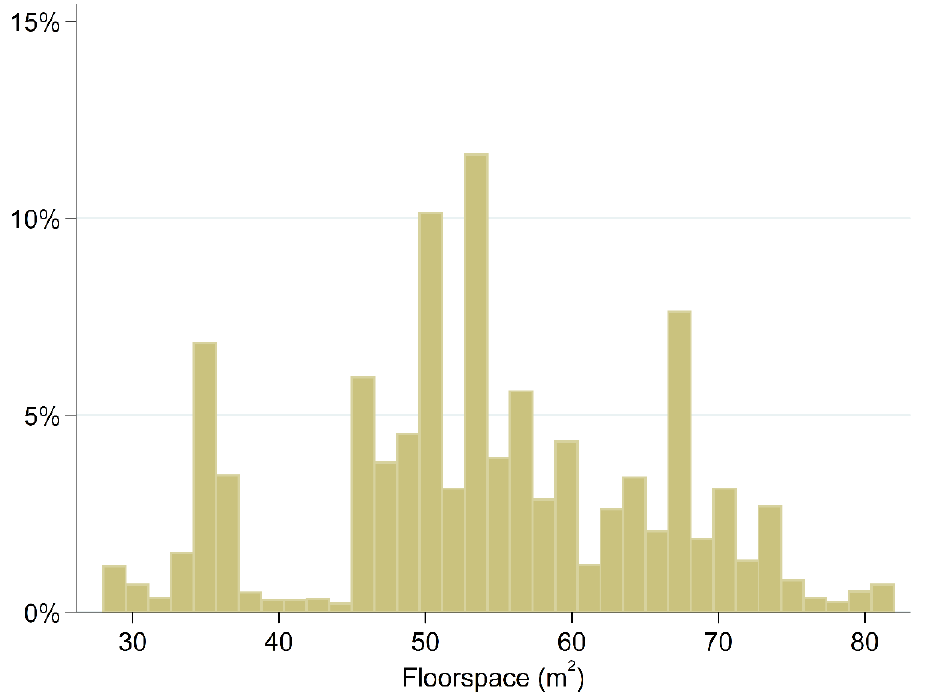
Figure 2. Distribution of floorspace.